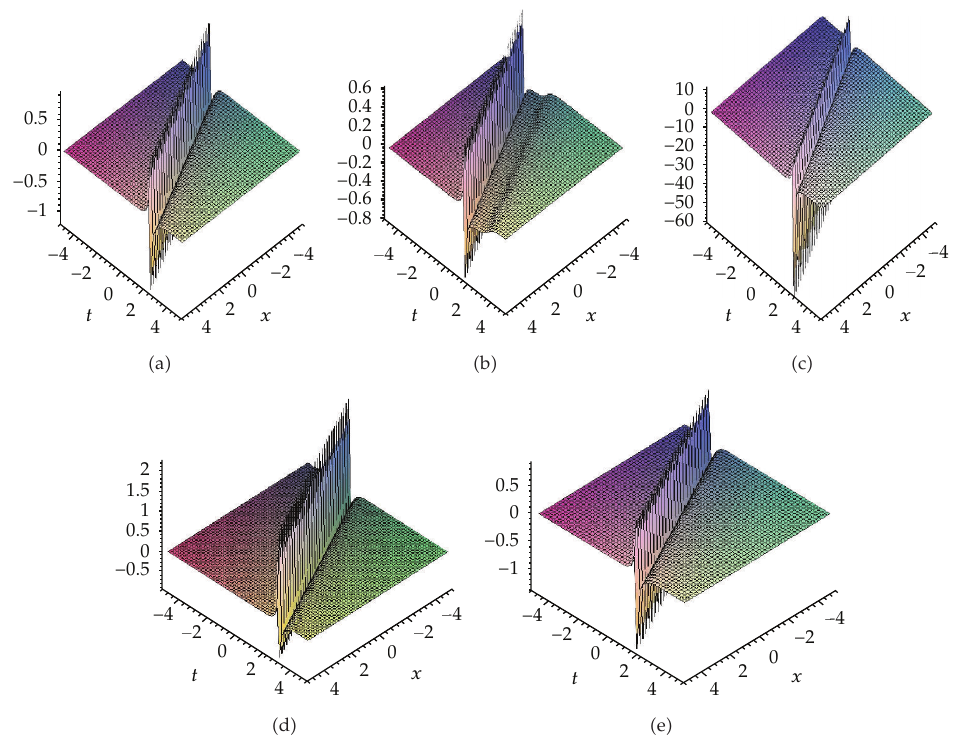
Figure 4: Evolutional behaviour of u 2 describes singular wave solution: (cid:3) a (cid:4) p (cid:7) q (cid:7) 1; (cid:3) b (cid:4) p (cid:7) 1 / 32 , q (cid:7) 1 / 33; (cid:3) c (cid:4) p (cid:7) 23 , q (cid:7) 32; (cid:3) d (cid:4) p (cid:7) 1 / 13 , q (cid:7) 11; (cid:3) e (cid:4) p (cid:7) 13 , q (cid:7) 1 / 11 .